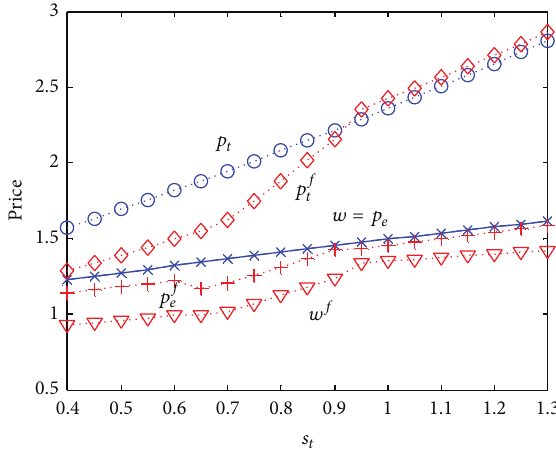
Figure 3: Effect of fairness channel profit distribution on channel pricing.